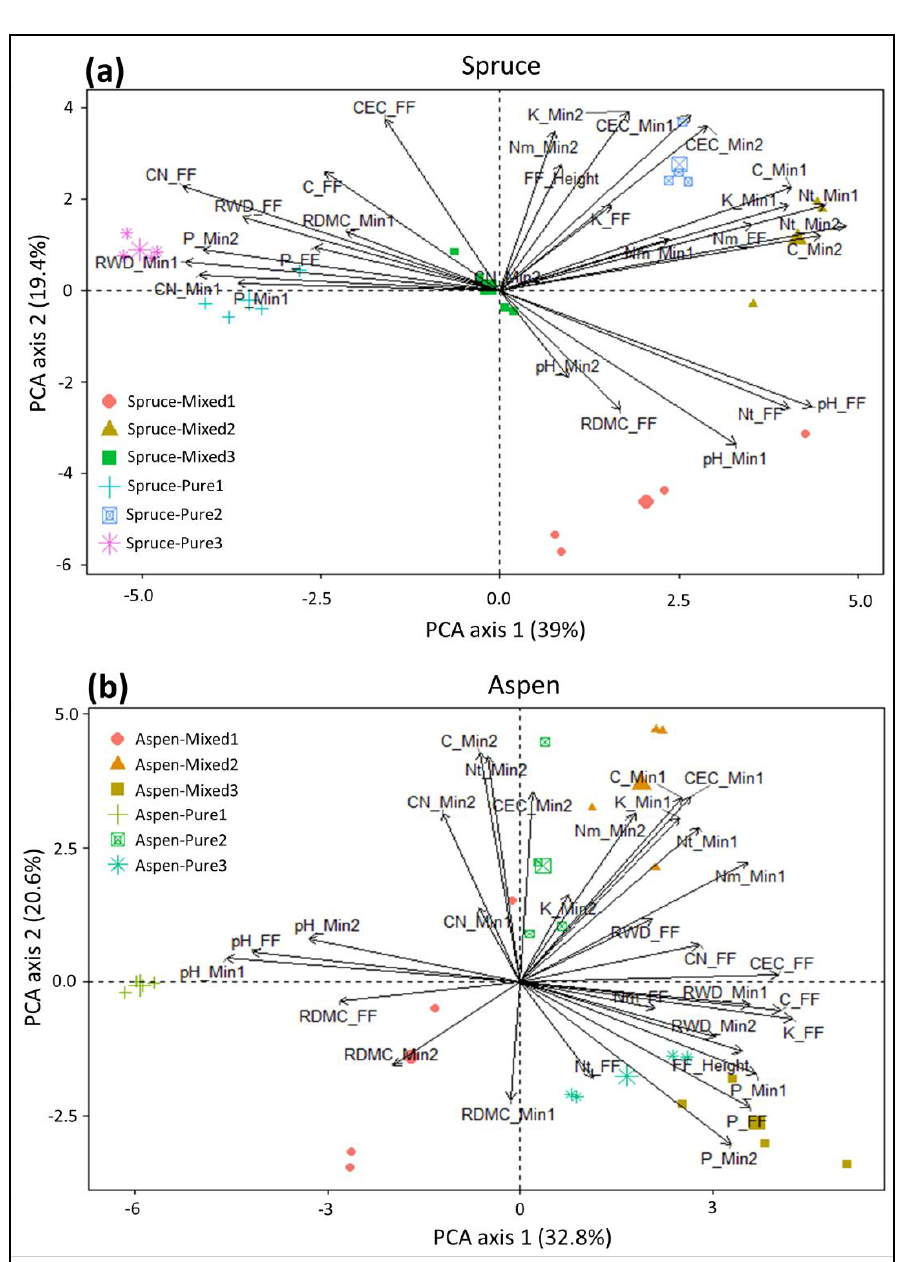
Figure 5. Principal component analysis comparing rooting patterns of black spruce ( a ) and trembling aspen ( b ) between pure and mixed stands. Variables included in the analyses are C:N ratio, pH, total carbon (C), total nitrogen (Nt), Ammonium (Nm), phosphorus (P), potassium (K), exchangeable cations (CEC) and depth of the organic layer (FF height), fine root biomass (FRB), and root dry matter content (RDMC) of the two species in respective pure and mixed stands affected by site (1–3). FF, Min1, and Min2 refer to organic, mineral soil at 0–15 cm, and mineral soil at 15–30 cm, respectively.